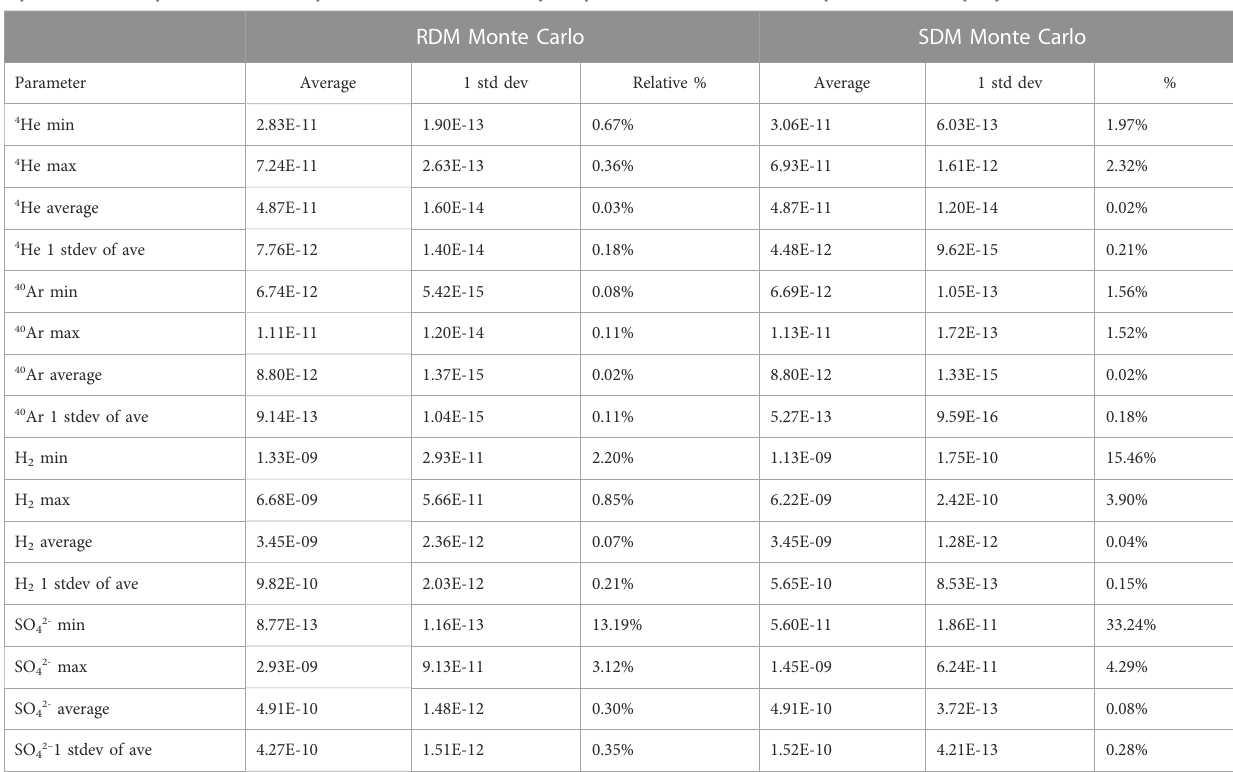
TABLE 3 Average, standard deviation, and relative percentage of each statistic presented in Table 2 (min, max, average, standard deviation) for each element. Theseweredeterminedbygeneratinganadditional10discretedatasetsof100,000valuesusingthesameapproachasoutlinedinthemaintext.Foreachdataset of 100,000 the min, max, average and standard deviation was then calculated as with those presented in Table 2 for the full data set. These were then compiled fromthe10datasetsandanaverageandstandarddeviationwascalculatedforeachoftheseoutputs.Additionally,therelativepercentagethestandarddeviation represents with respect to the mean is presented to show variability. All production rates are in moles per bulk m 3 rock per